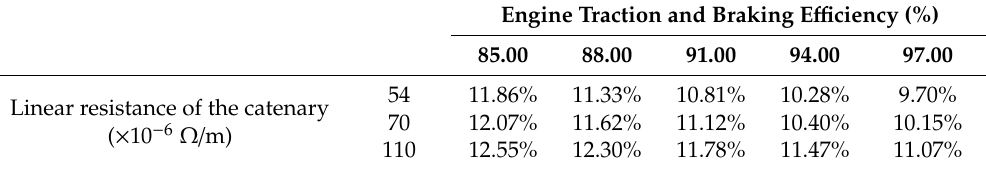
Table 3. Di ff erence (in %) in energy consumption at the electrical substations between the holding speed with braking and the holding speed without braking and final coasting driving strategies for di ff erent values of the energy traction and braking e ffi ciency and the linear resistance in the Puertollano–Ciudad Real section for the commercial running time (13 min).